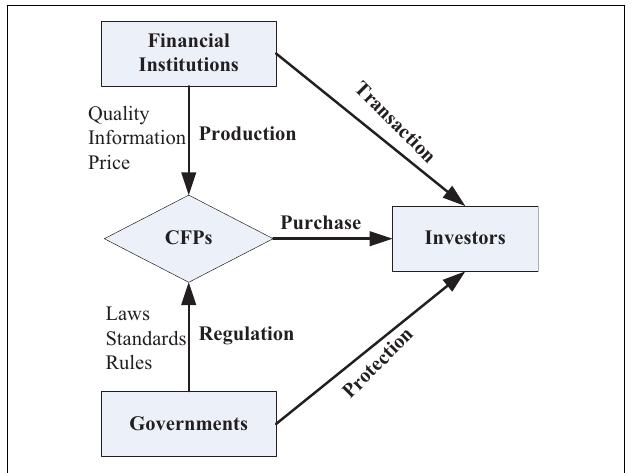
FIGURE 1 | The relationship among CFPs stakeholders. FIGURE 2 | The process of the tripartite regulation game in CFPs.